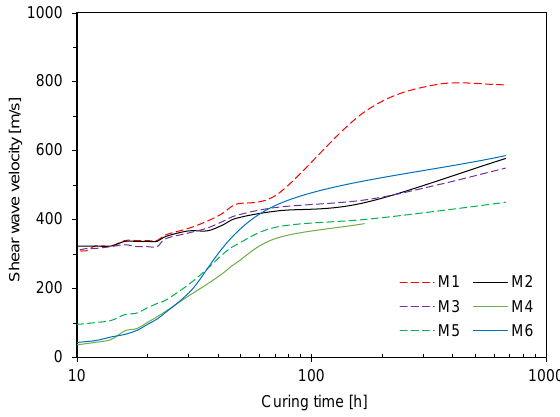
Figure 8. Variation in shear wave velocity along the curing time.